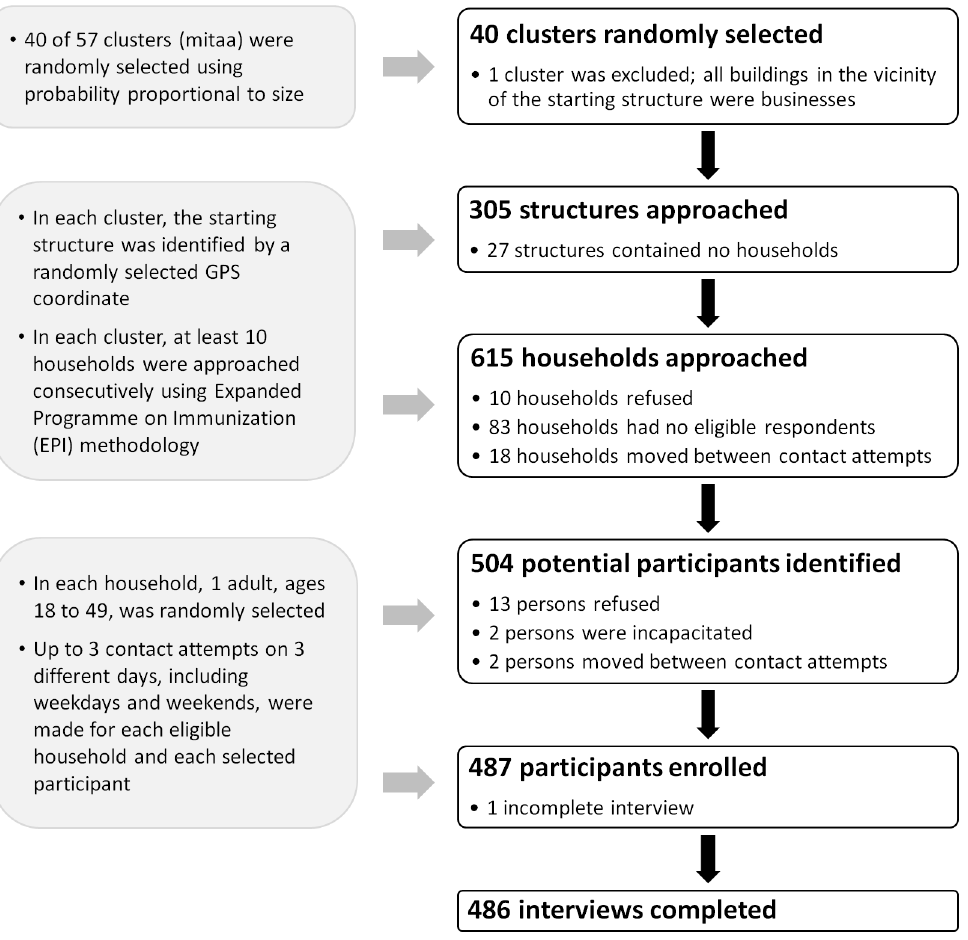
Figure 2. Participant enrollment. Flowchart summarizing enrollment of a random community sample for participation in the discrete choice experiment.